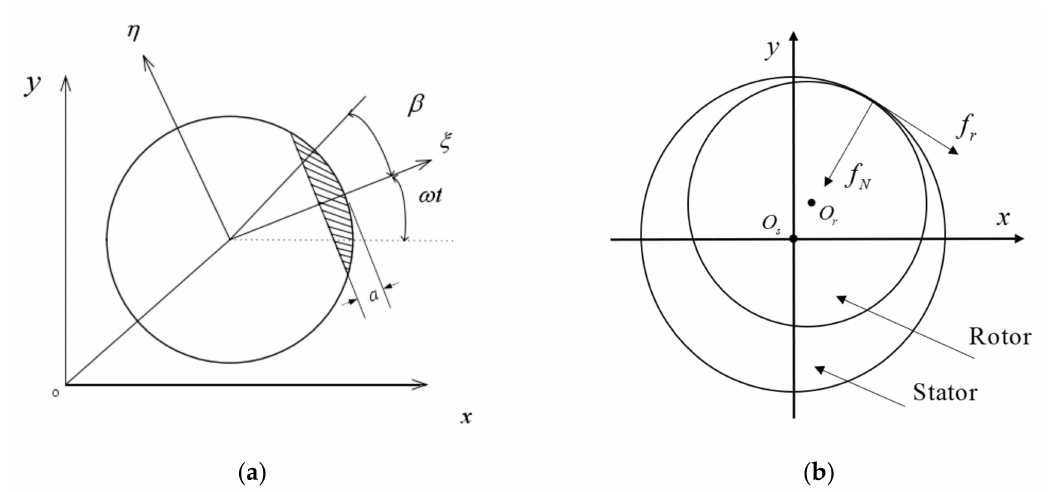
Figure 2. Schematic diagram of the cracked section and rubbing model. ( a ) The cracked model. ( b ) The rub-impact